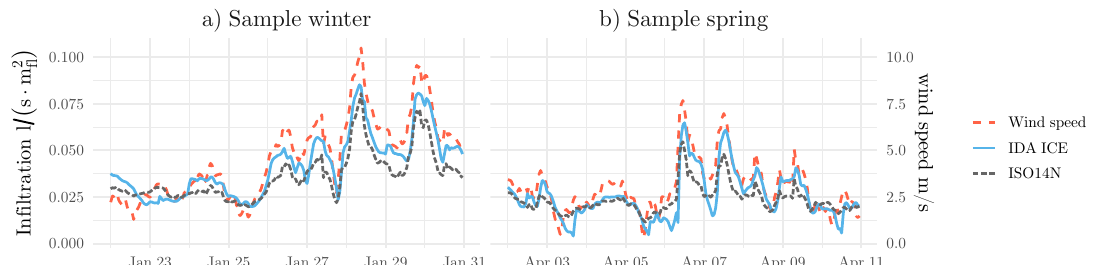
Figure 6. Comparison with IDA ICE on air infiltration. The solid blue line shows an infiltration level from IDA ICE, a gray-dotted line shows an infiltration level from the ISO14N model, and the dashed red line shows the meteorological wind speed (scale on right-hand